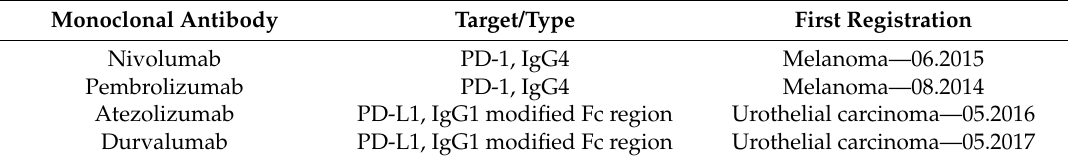
Table 1. The first agents for PD-1/PD-L1 inhibition in